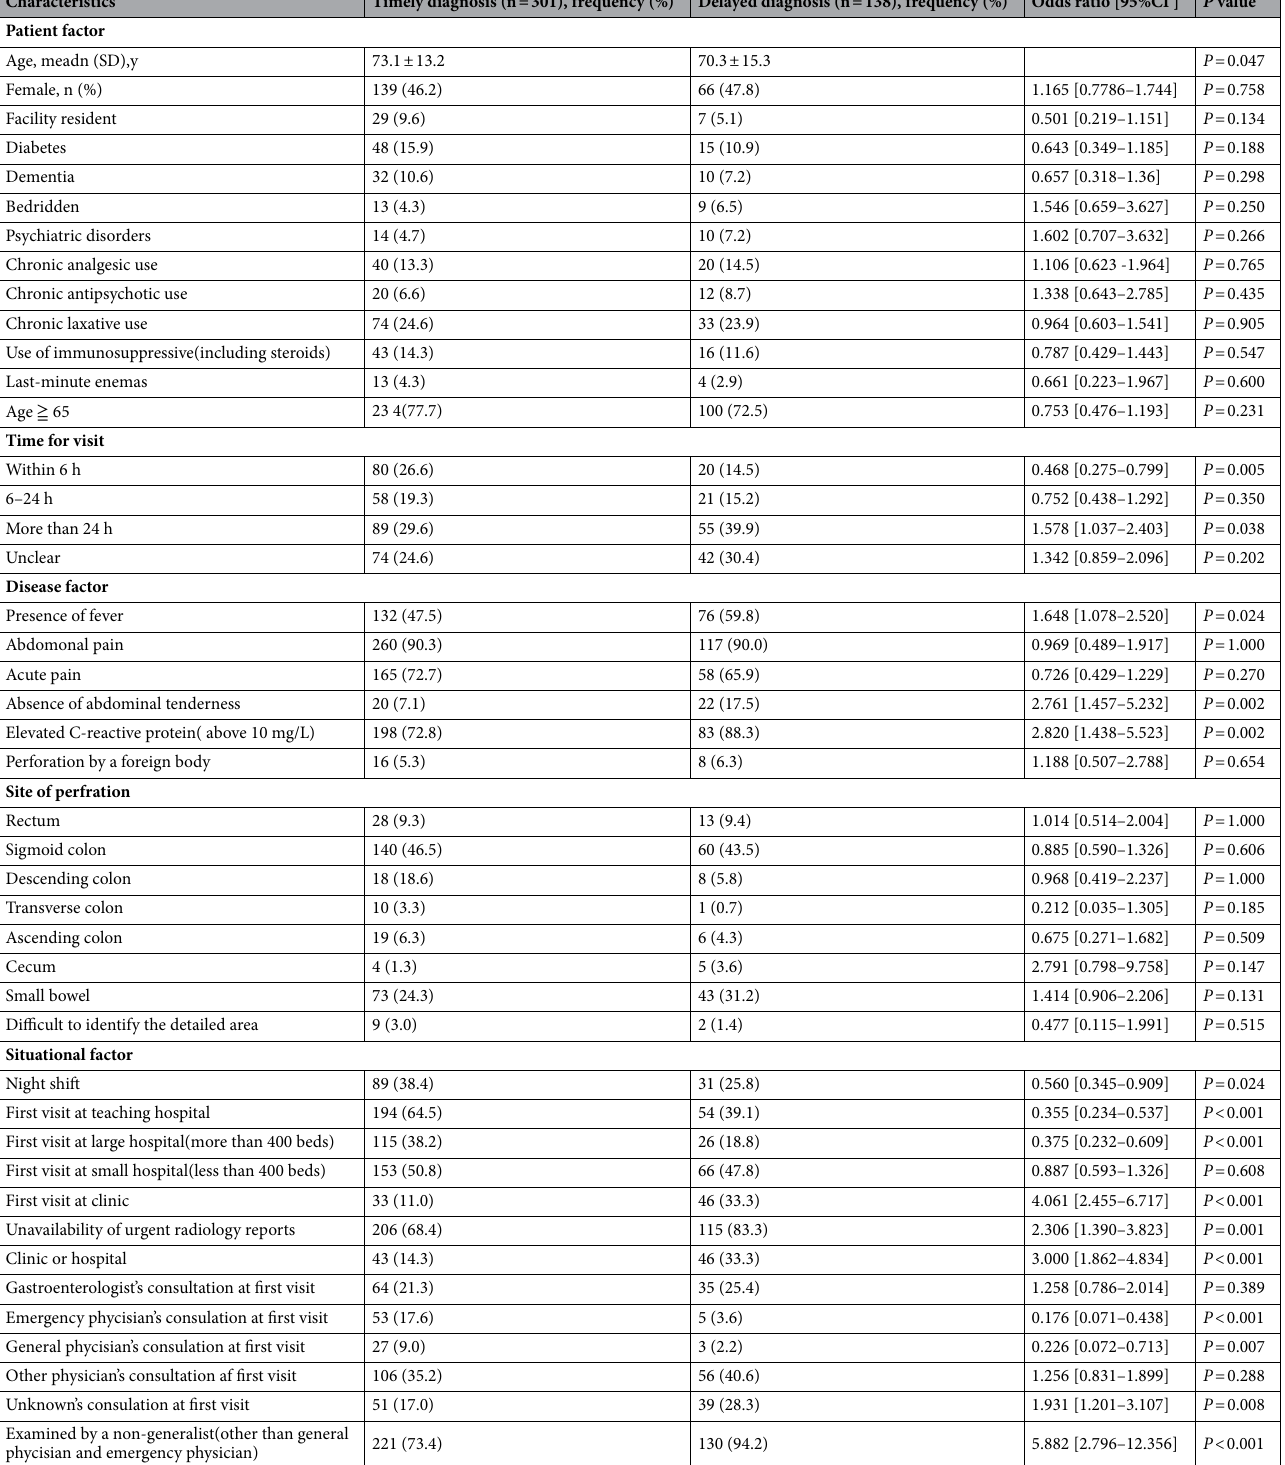
Table 1. Comparison of the characteristics for participants and factors associated with the